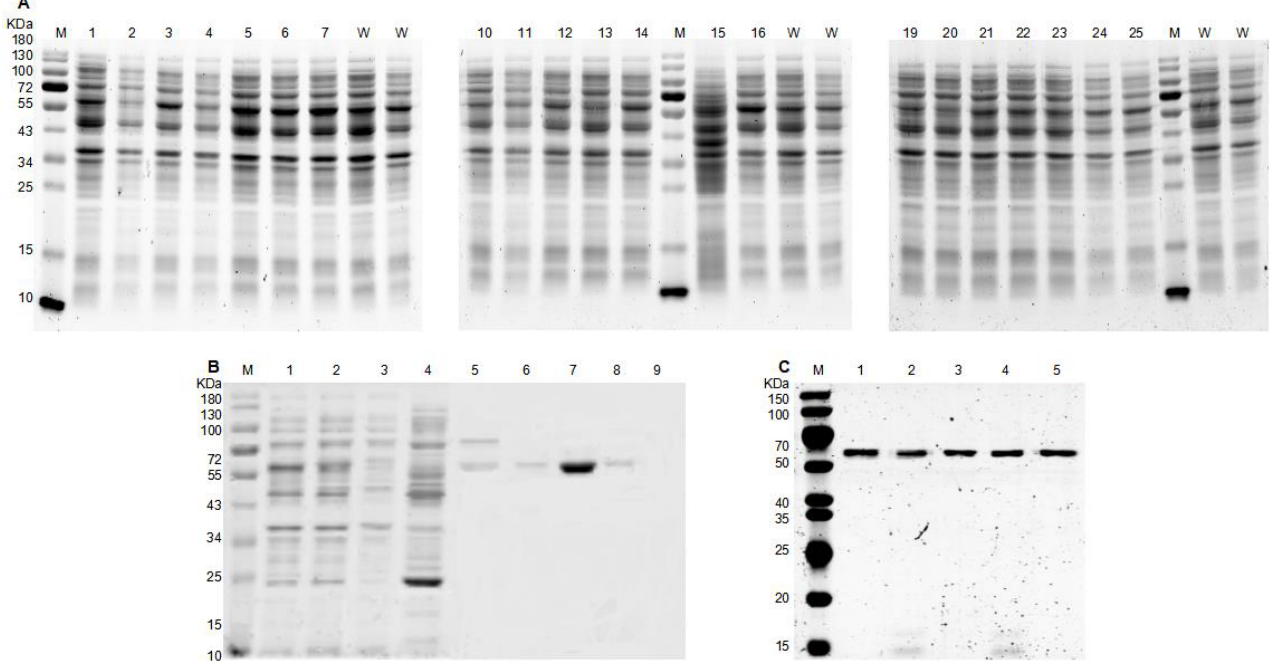
Figure 4. SDS-PAGE analysis of the recombinant proteins in the study. ( A ) The crude proteins of wild type Xyl21 and its variants. Lane M: molecular mass marker; Lane 1 – 7, 10 – 16, 19 – 25: the crude proteins of various variants; Lane W: the crude protein of wild type Xyl21. ( B ) The crude proteins and purified proteins of wild type Xyl21. Lane M: molecular mass marker; Lane 1: the crude enzyme of Xyl21; Lane 2: eluent of 0 mM imidazole; Lane 3: eluent of 10 mM imidazole; Lane 4: eluent of 60 mM imidazole; Lane 5: eluent of 80 mM imidazole; Lane 6: eluent of 100 mM imidazole; Lane 7: eluent of 200 mM imidazole; Lane 8: eluent of 300 mM imidazole; Lane 9: eluent of 500 mM; ( C ) The purified recombinant proteins of its variants. Lane M, molecular mass marker; Lane 1, wild type Xyl21; Lane 2, triple mutant Xyl21-A16; Lane 3, single mutant K16R; Lane 4, single mutant L94I; Lane 5, single mutant K262N. SDS-PAGE analysis used 12% acrylamide gel and dye with Coomassie Brilliant Blue R-250 staining. To better compare the enzymatic activity and product tolerance of variants, the en- zymatic activities of the purified mutant enzymes were measured by adding equal con- centrations of protein at the optimal temperature and pH. As demonstrated in Figure 5, the variant named Xyl21-A16 was ultimately found to display significant improvements in both xylose and ethanol tolerance ( p < 0.01 in both cases). In the presence of 0.3 M xylose, mutant Xyl21-A16 exhibited 127.07% relative activity, which was higher than the wild type (107.36%). Although the activities of mutant Xyl21-A16 and the wild type were both inhibited when the concentration of xylose was increased above 0.6 M, mutant Xyl21-A16 retained 24.82 – 87.55% relative activity in the presence of 0.6 M to 2.1 M xylose, while the wild type only retained 21.48 – 74.31% relative activity at the same concentration of xylose. Similar to the xylose tolerance, the ethanol tolerance of the mutant Xyl21-A16 enzyme was significantly increased compared to the wild type Xyl21, as shown in Figure 5B. The rela- tive mutant Xyl21-A16 exhibited 193.10% and 189.65% relative activity in the presence of 5 and 10% ( v/v ) ethanol, respectively, while the wild type retained 168.07% and 154.08% relative activity, respectively. In the presence of even higher ethanol concentrations (20 and 30%, v/v ), mutant Xyl21-A16 also exhibited significantly better tolerance than the wild type Xyl21. Furthermore, the thermostability of Xyl21-A16 was significantly improved, so that it retained between 92.76 and 67.82% residual activity after incubation at 50 and 55 °C for 10 minutes, respectively, while the wild type only retained 84.82 and 39.55% rela- tive activity after the same treatment, respectively (Figure 5C). In addition, the optimal temperature, optimal pH, and specific activity of mutant Xyl21-A16 were identical to the